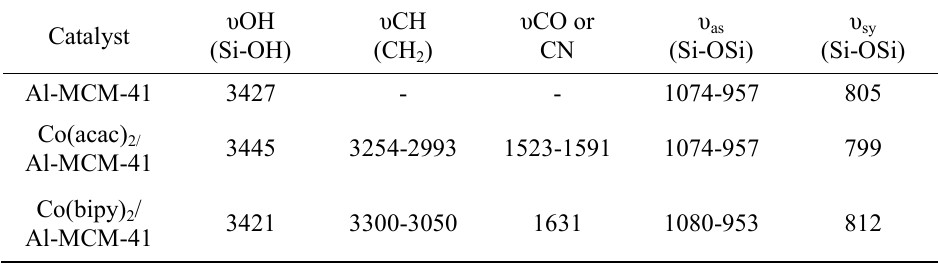
Table 2. FT-IR band assignments in wavenumbers (cm -1 ) obtained for Al-MCM-41 and immobilized cobalt complexes within the nanoreactors of